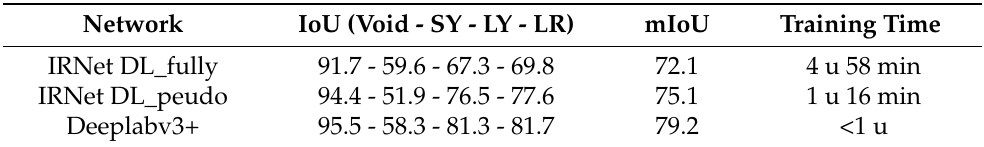
Table 3. Quantitative performance of IRNet, DL_pseudo and DL_fully. The IoU is given per class (void, SY, LY and